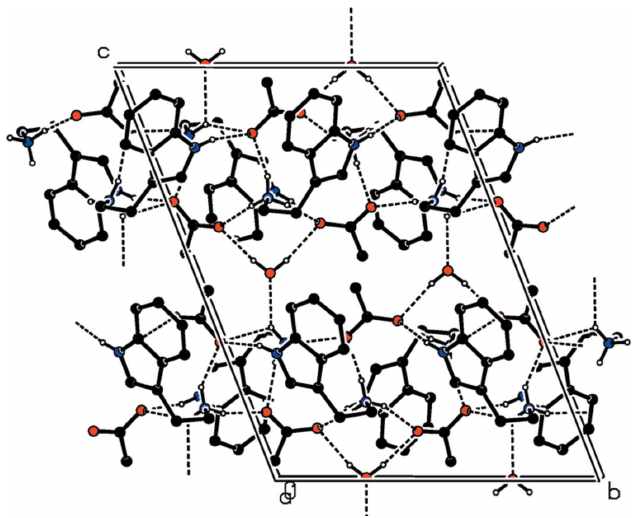
Figure 2 A view along the a axis of the crystal packing of the title molecular salt. The N—H (cid:2)(cid:2)(cid:2) O and O—H (cid:2)(cid:2)(cid:2) O hydrogen bonds are shown as dashed lines (see Table 1). For clarity, the C-bound H atoms have been